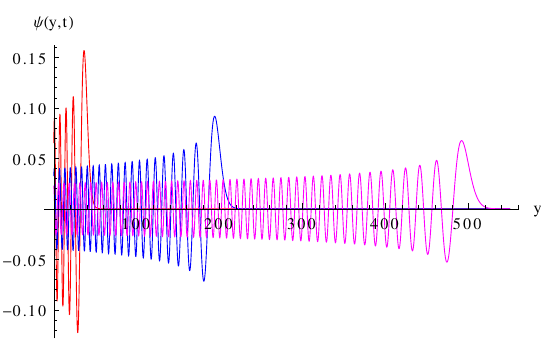
Figure 3 . Plot of the Airy function (4.10) for t = 40 (red), t = 200 (blue) and t = 500 (magenta). Notice the very e(cid:14)cient